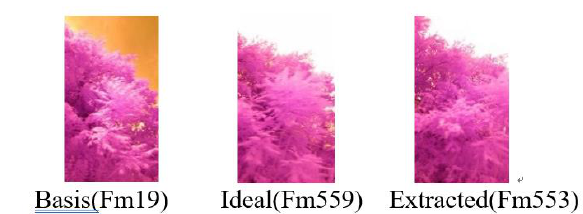
Figure 5. Mismatch image at maximum